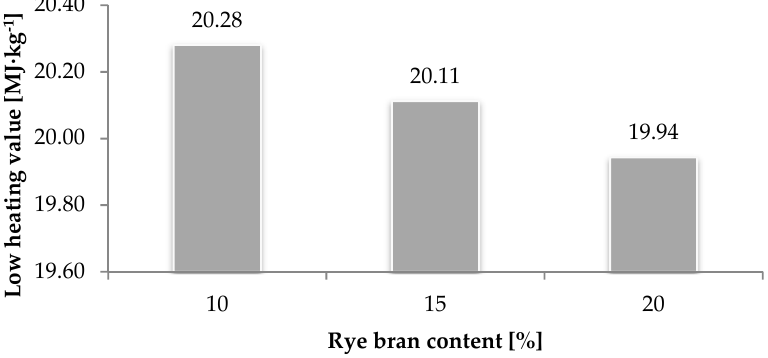
Figure 5. Dependence of the LHV of cherry stone granules on the content of rye bran.